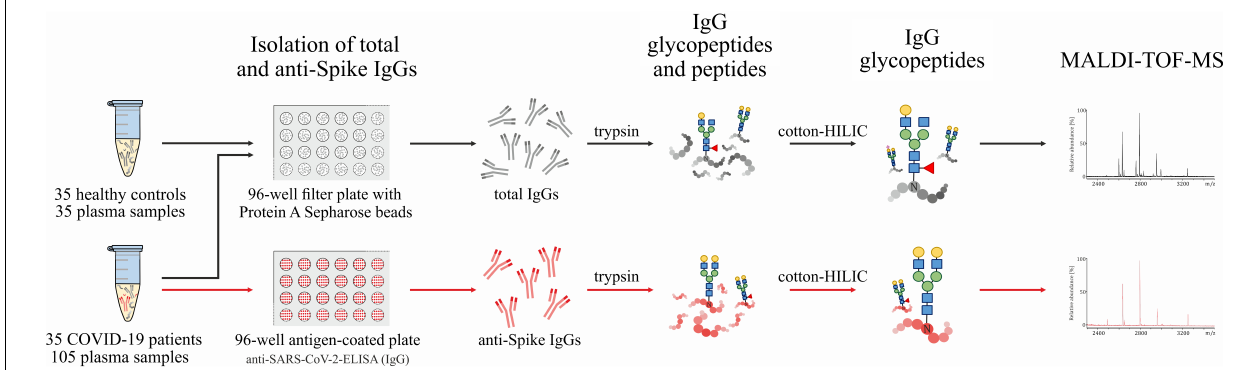
FIGURE 1 | Schematic representation of the analytical workflow used in this